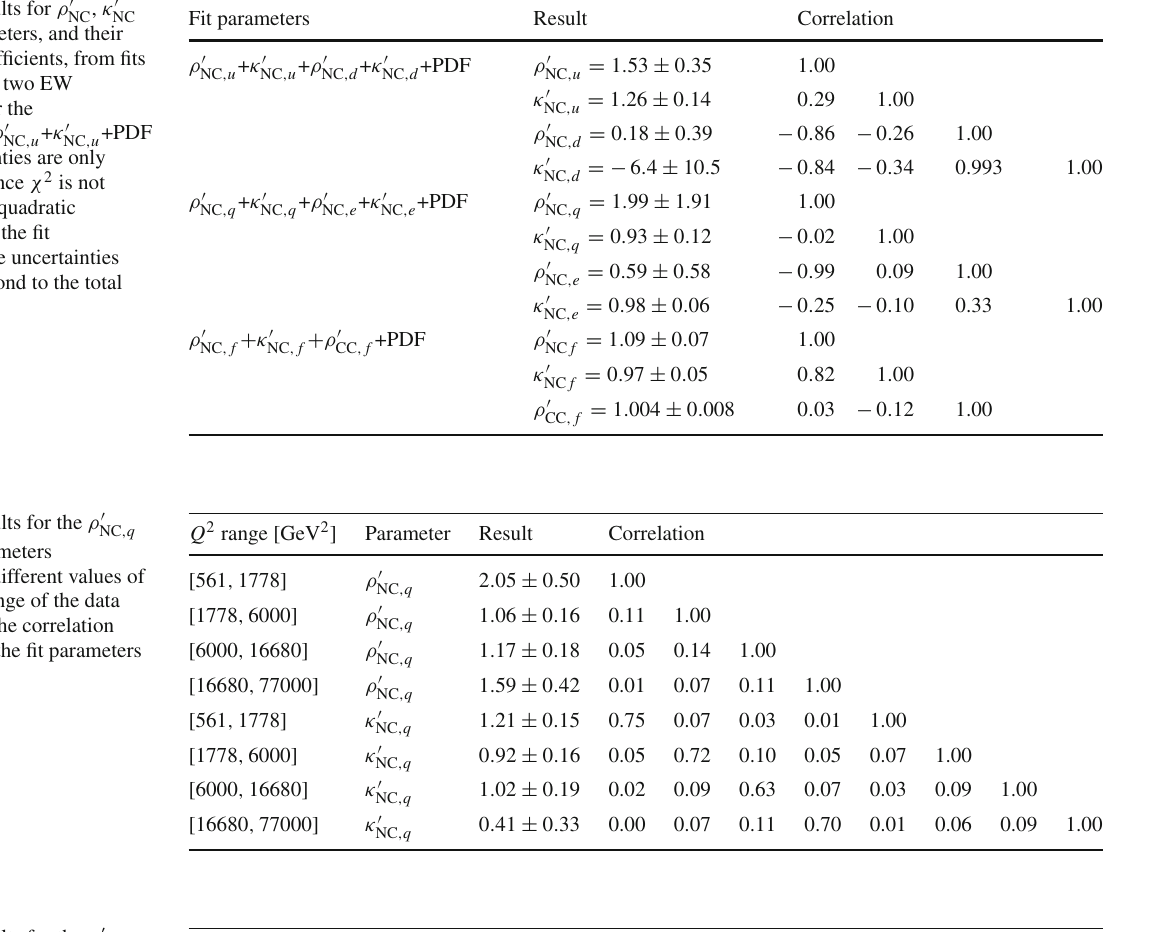
Table 12 Results for ρ (cid:6) and ρ (cid:6) parameters, and their CC correlation coefficients, from fits with more than two EW parameters. For the ρ (cid:6)